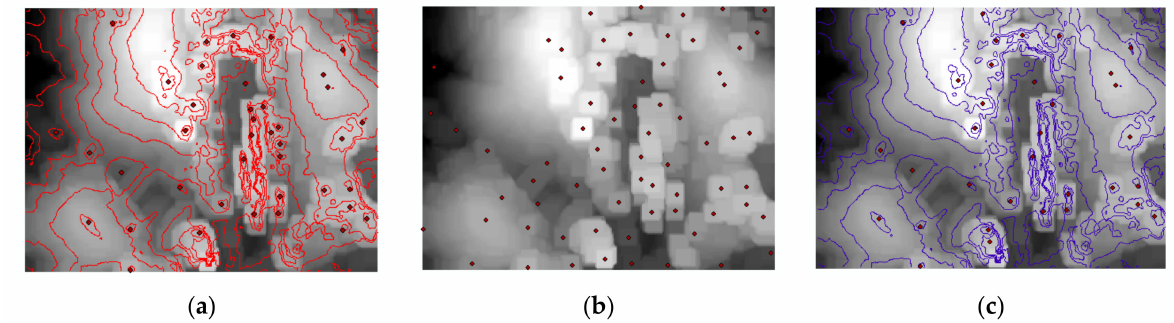
Figure 18. Distribution maps extracted by the traditional Mountain Vertices Extraction Methods using the third dataset.